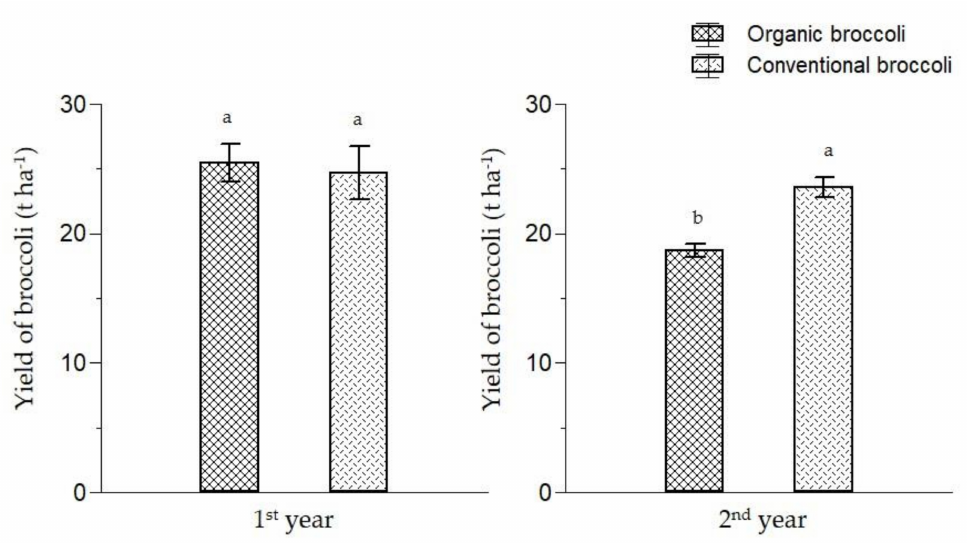
Figure 4. Impact of the di ff erent farming systems (organic vs. conventional) on fresh weight (FW) of broccoli flower heads during the 1st and 2nd experimental year. For each year, di ff erent letters above each bar indicate significant di ff erences according to the t-test ( p < 0.05). Vertical bars indicate standard errors of means ( n =